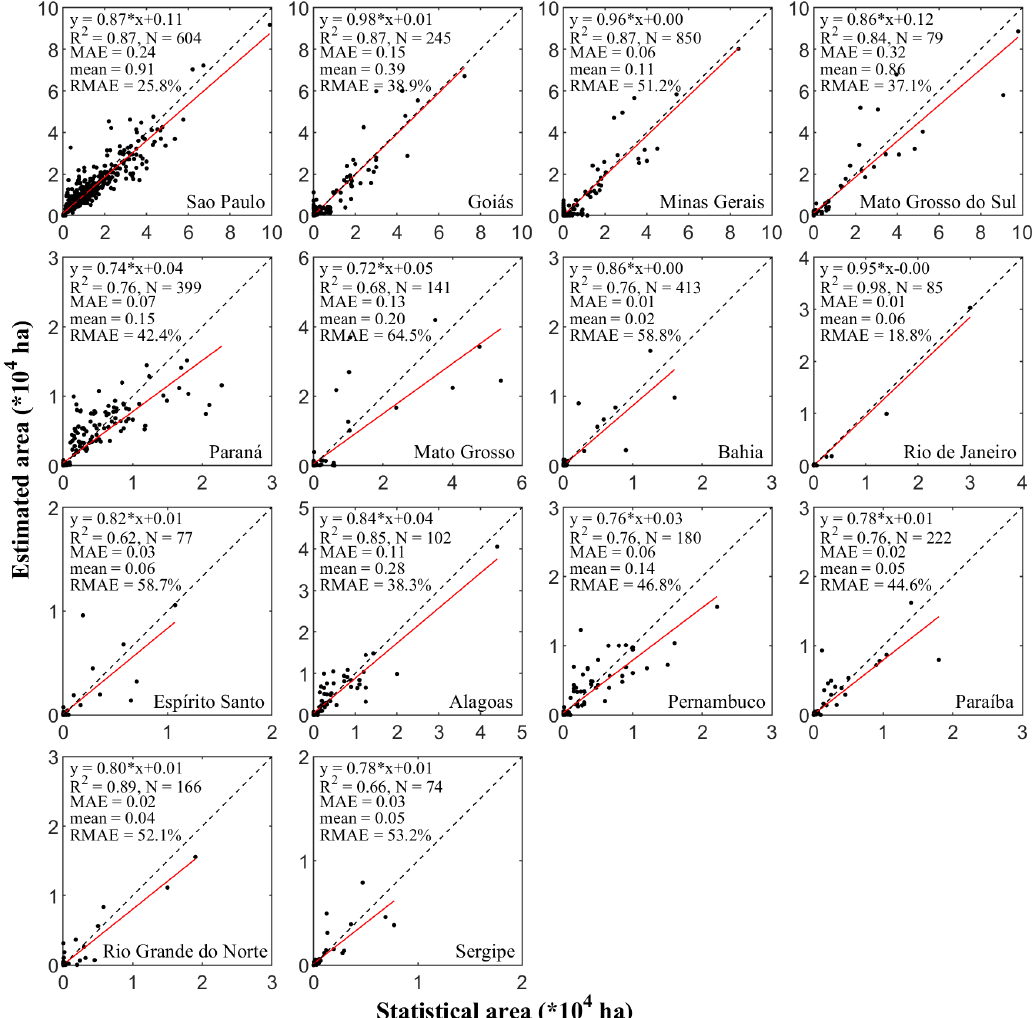
Figure 11. Comparisons between the agricultural statistical harvest area and the estimated harvest area of sugarcane at the municipality level for the 14 states in 2018. “N” and “mean” represent the number and mean value of all the valid statistical data in each figure,